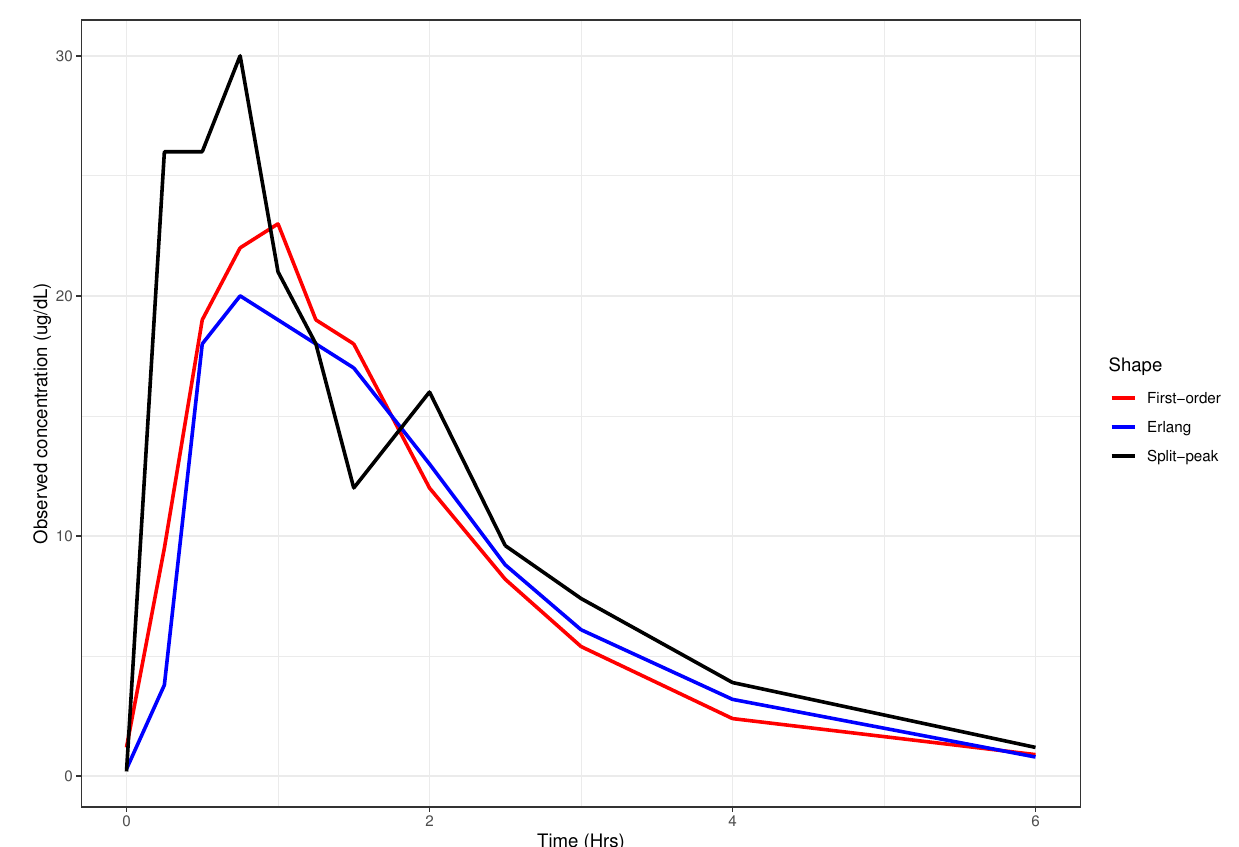
Figure 1. Observed concentration-time profiles for three representative shapes. (red) presents the first-order process; (blue) presents the Erlang process; (black) presents the mixed first-order and Erlang processes.